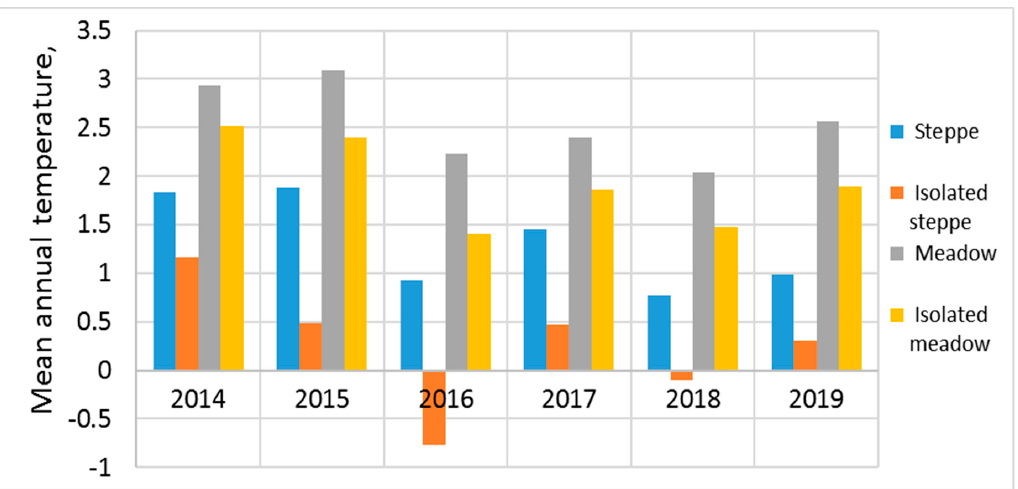
Figure 6. The change in the average annual temperature of alas soils at a depth of 0.2 m. The F-ratio value is 97.30306. The p -value is < 0.00001. The result is significant at p < 0.05.